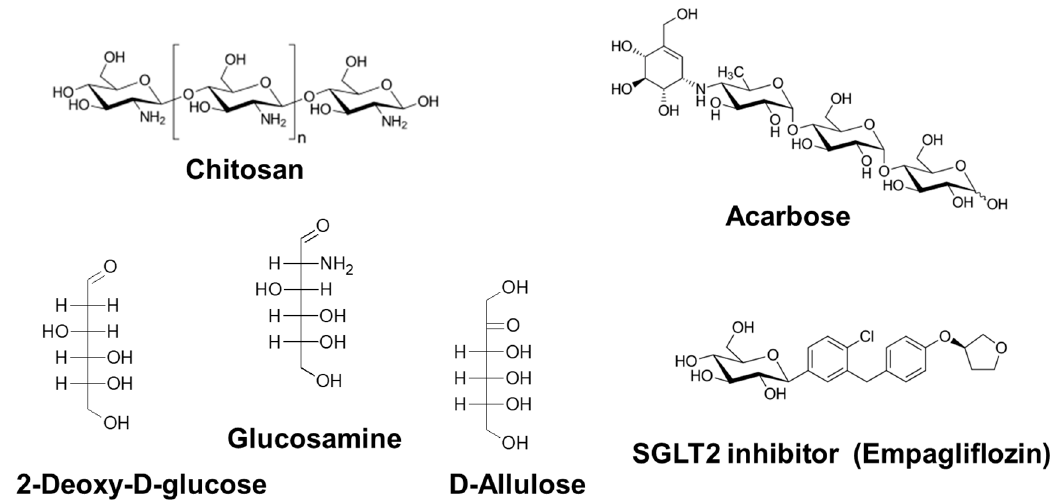
Figure 3. Chemical structures of upstream-type CRMs.